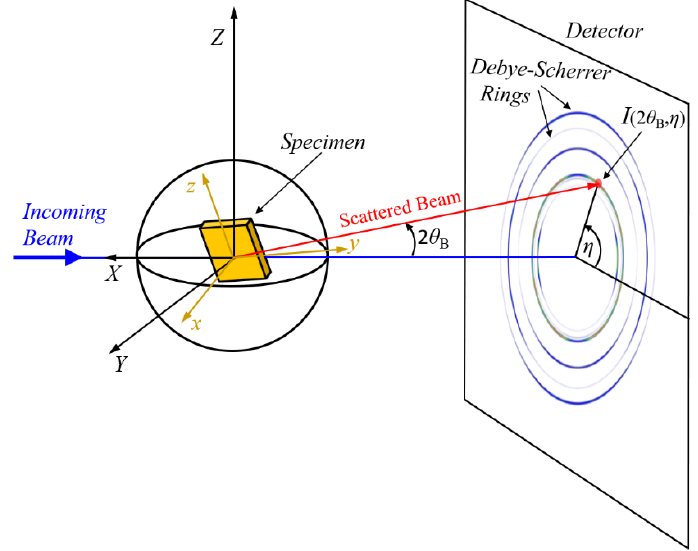
Figure 1. Schematic figure of the X-ray di ff raction measurement geometry. K L = { X , Y , Z } is the laboratory coordinate system, K s = is the specimen coordinate system, θ B is the Bragg and η is the azimuth angle of the scattered beam. The ideal orientation of a texture component, is interpreted as a three-dimensional rotation matrix with z-x-z convention: